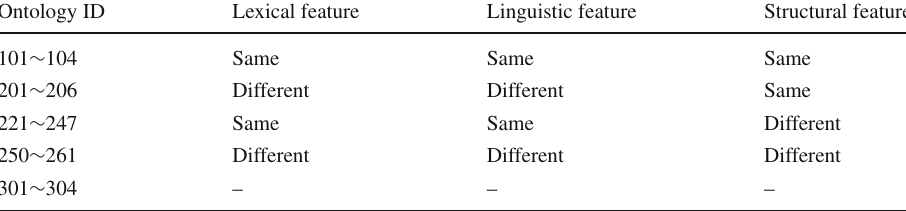
Table 8 Relevant descriptions Ontology ID Lexical feature Linguistic of OAEI’s benchmark track